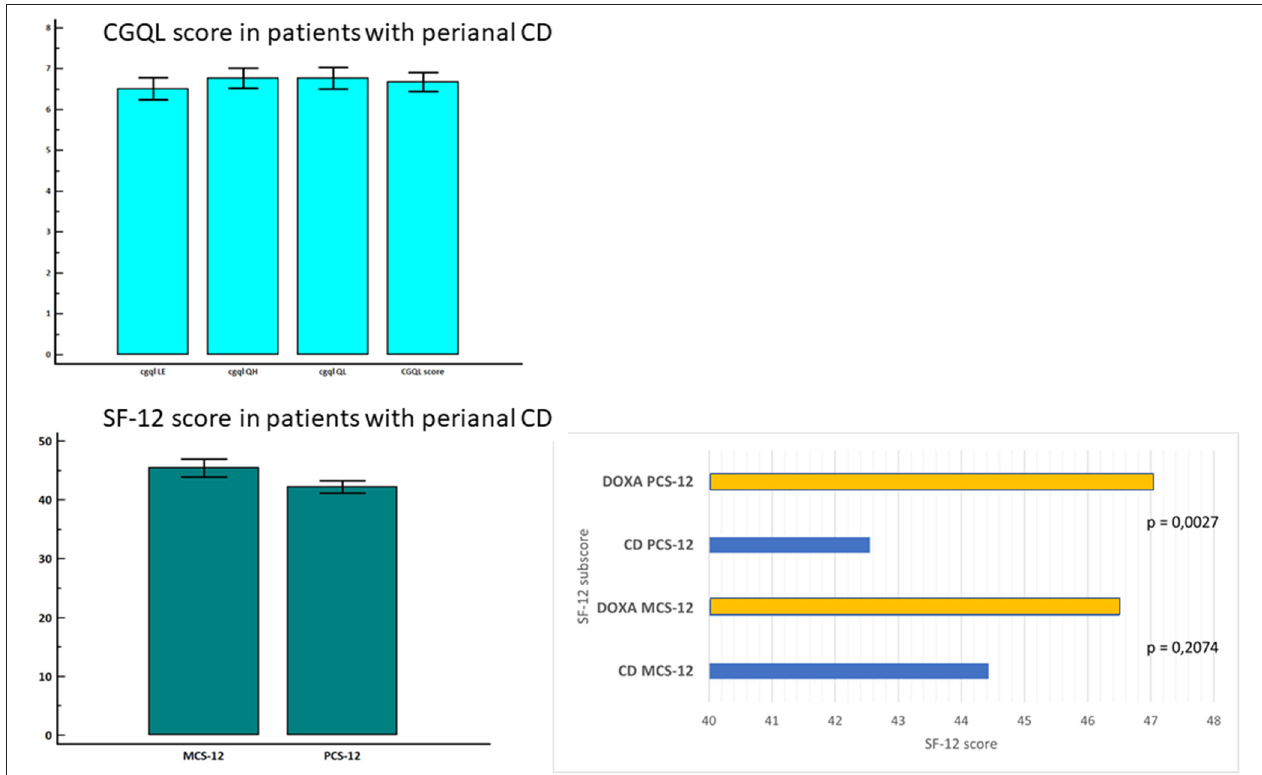
FIGURE 2 | Quality of life in patients with CD with perianal disease and in healthy controls.